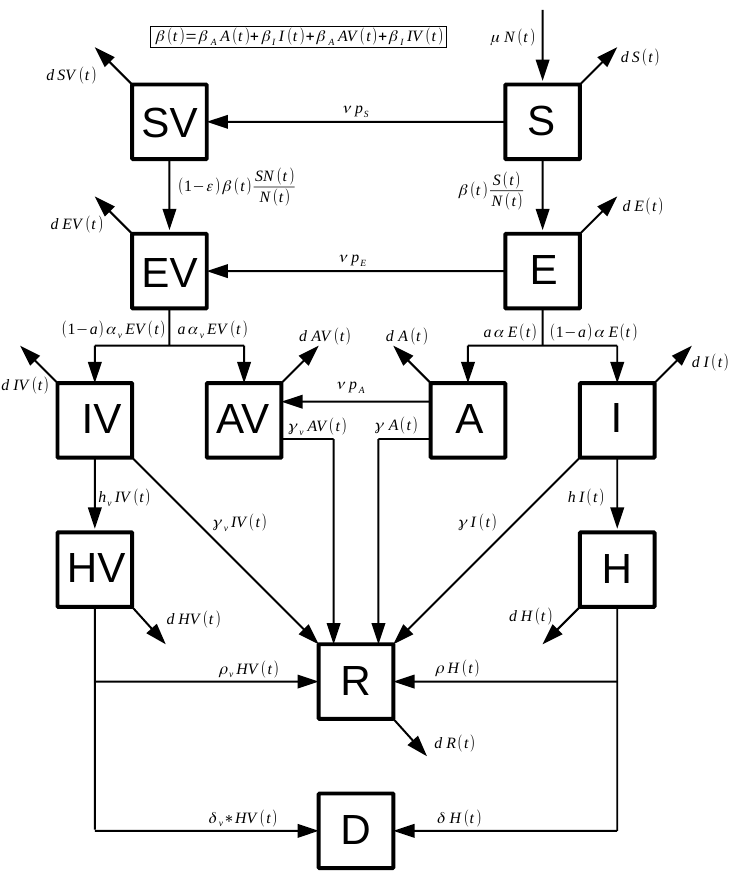
Figure 1. Diagram for the COVID-19 mathematical model (1). The boxes represent the subpopulation and the arrows the transition between the subpopulations. Arrows are labeled by their corresponding model